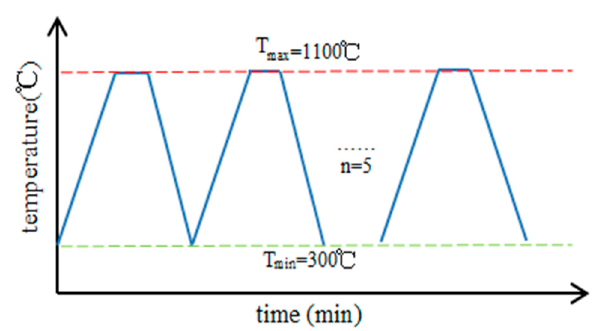
Figure 12. Heat resistance test results at high temperature. 4. Thermal Effect on Sensor Based on the principle of eddy current sensing, temperature change will leads to the coil parameters like permeability and conductivity change. Then the measuring results will be influenced. In order to know how the inductive sensor can be affected by high temperature, experiment method was used to get the influence of temperature on sensor. 4.1. Experiment method The research adopted the equipment as Figure 9 and Figure 10 show to create the adjustable temperature environment and measure coil parameters ( L, R ) without target under test at different temperature. The experiment temperature increased from 500 ℃ to 1100 ℃ . The equivalent measurement circuit of LR is shown as Figure 13. The sensor coil is equivalent to a series resistor R and a pure inductor L. The divider resistor Rs was 7.5 Ω and the excitation signal was 4 MHz 3 Vpp AC voltage (U 0 ). When the environment temperature changes, coil inductance L and coil resistance R may both vary.